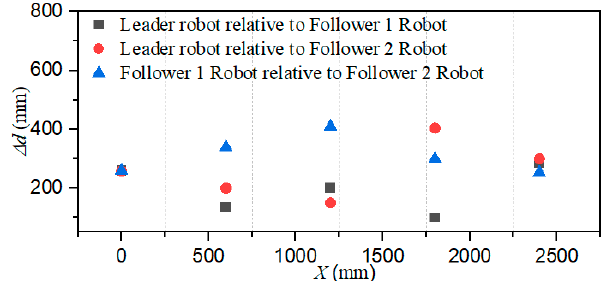
d Δ is the relative distance